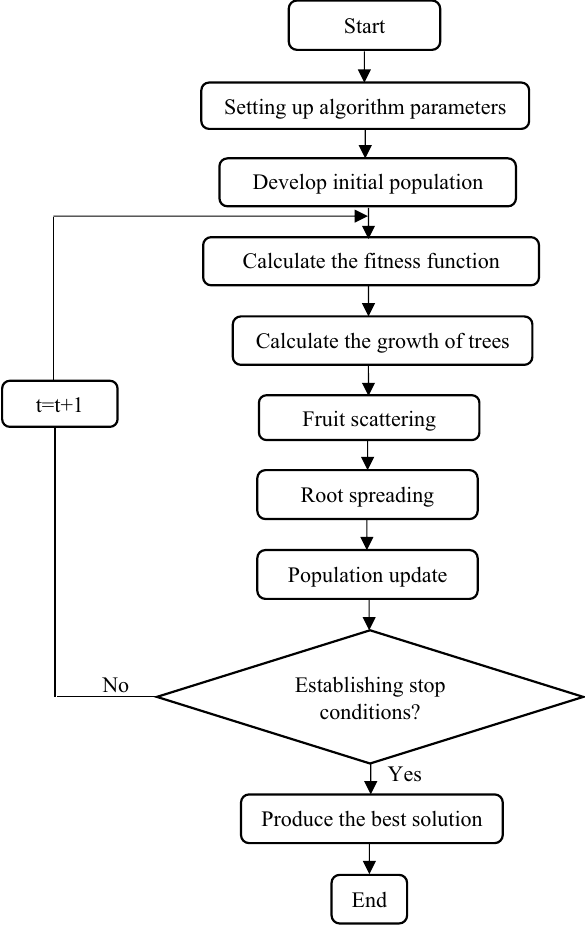
Fig. 2 Flowchart of the HTS